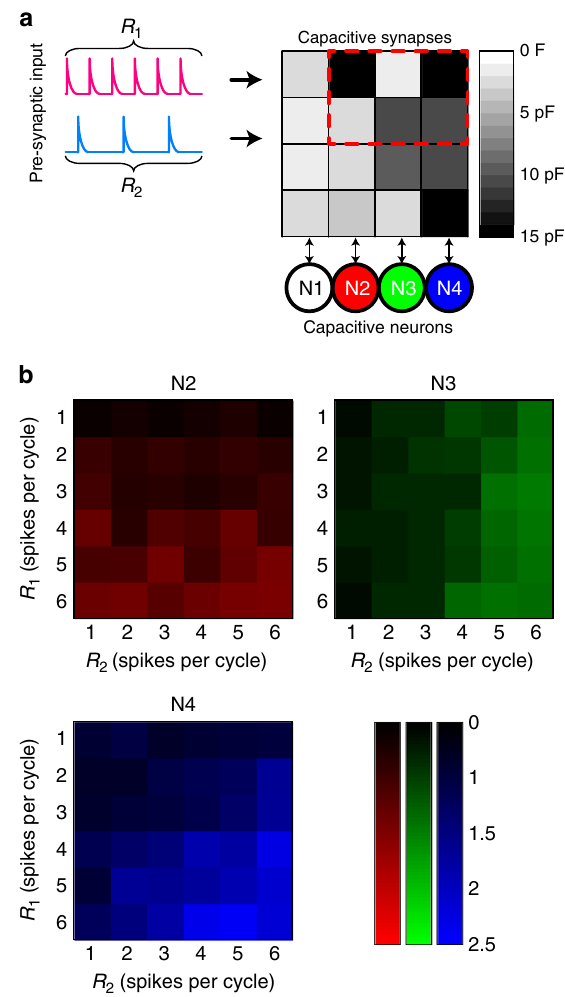
Fig. 5 Inference of the pre-synaptic signals with the capacitive neural network. a Schematic of the classi fi er. A 2 × 3 subarray of the neural network, as highlighted by the red dashed box, was used to classify the two-dimensional input vector consisting of non-overlapping voltage spikes at different rates, R 1 and R 2 spikes per period (see also Supplementary Figure 10). The NPM synapses were initialized to discrete states. b Color maps of the post-synaptic neuron integrate-and- fi re rate per input cycle (only the fi rst integrate-and- fi re cycle counts) as a function of the spiking rates of the two pre-synaptic